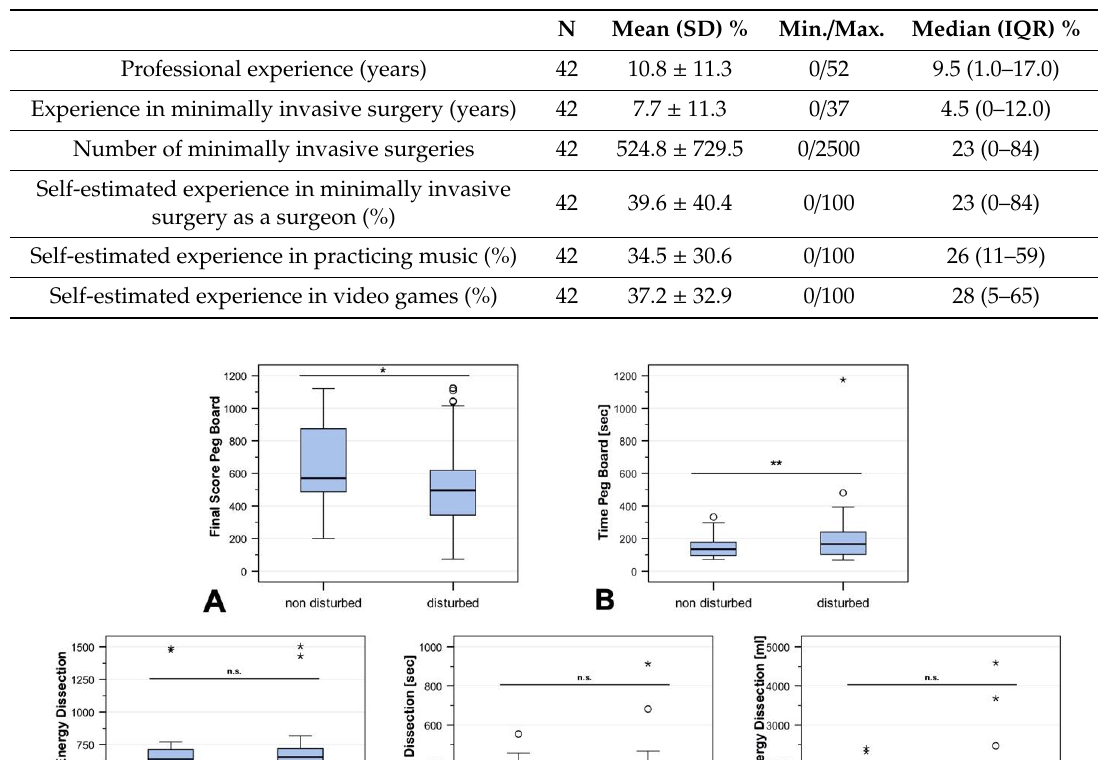
Table 1. Experience of the participants.